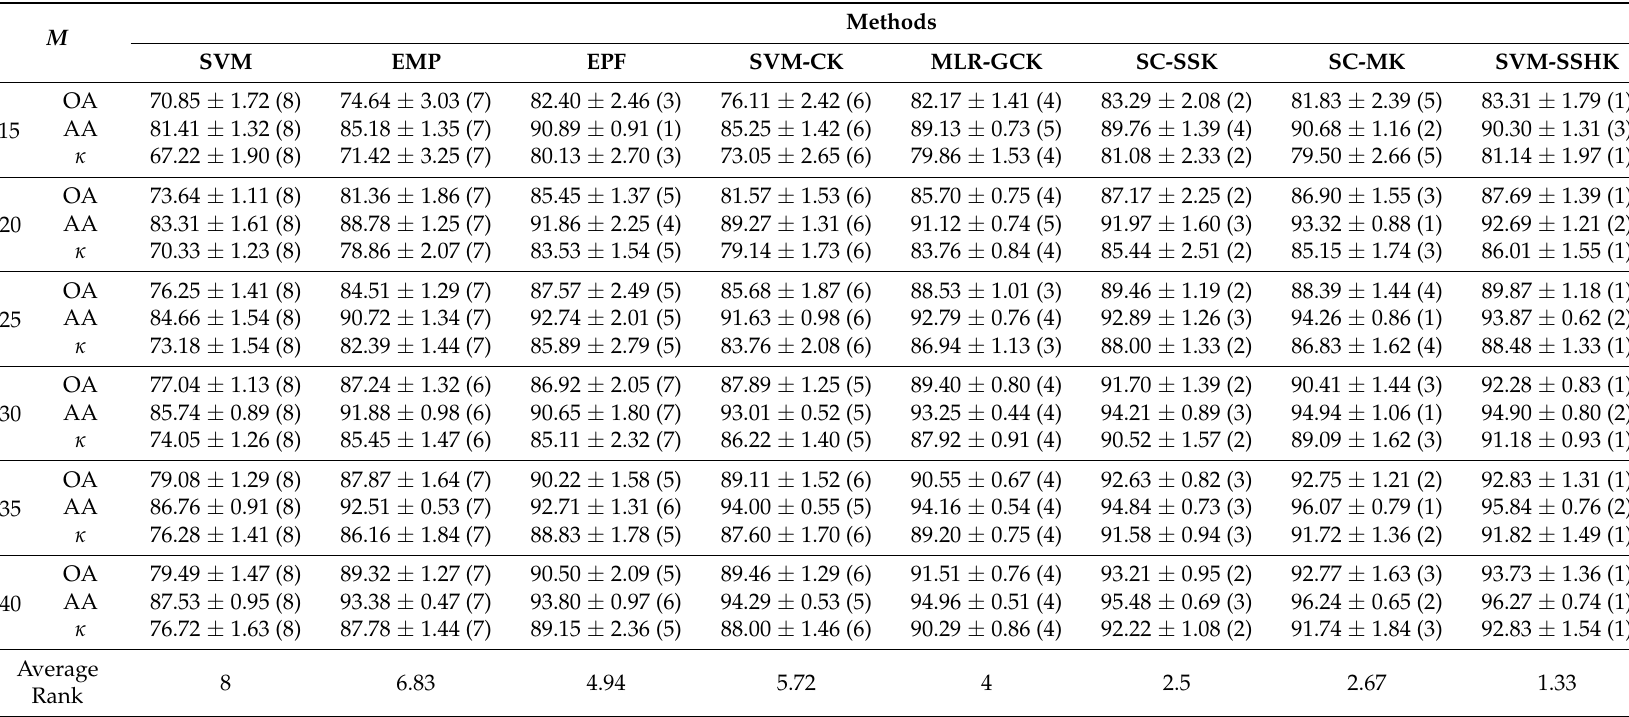
Table 3. Classification Results [Mean Accuracy (%) ± Standard Deviation] by Different Methods using Different Number of Training Samples for the IP Image. The best accuracies are indicated in bold in each